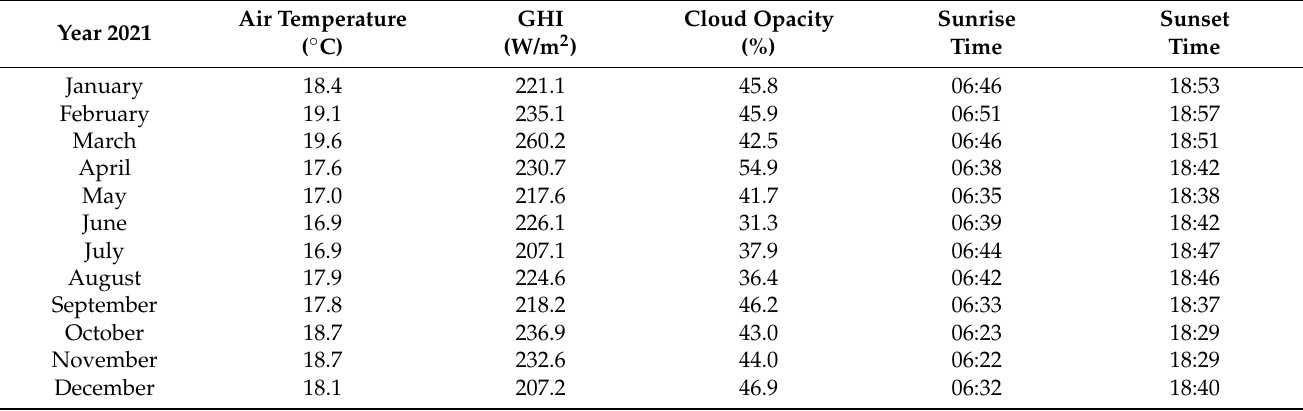
Table 6. Monthly average values of GHI, ambient temperature, and cloud opacity, as well as sunrise and sunset times at the beginning of the month, for the modelled Gionseri B mini-grid